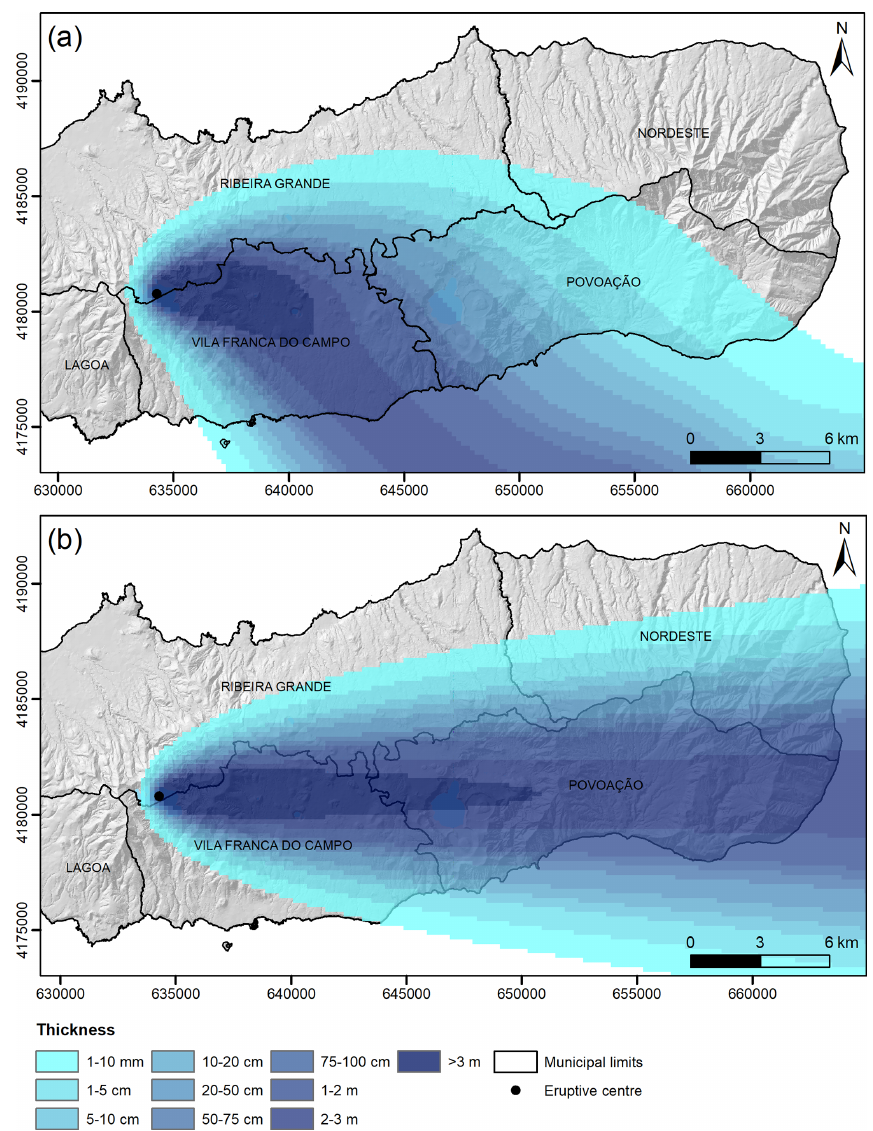
Figure 4. (a) Tephra fallout deposition from a VEI 5 Plinian eruption of Fogo volcano, considering the dominant winds for the summer period. (b) Tephra fallout deposition from a VEI 5 Plinian eruption of Fogo volcano, considering the dominant winds for the winter period. UTM coordinates, zone 26S, datum WGS 84.